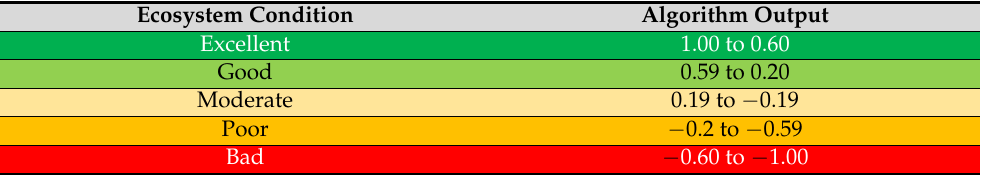
Table 2. Ecosystem condition algorithm rating scale and the relevant color scale as used in the MAES_GR